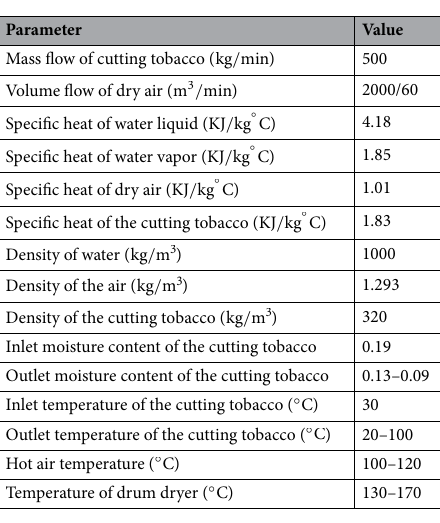
Table 8. The parameters of MOMPC.